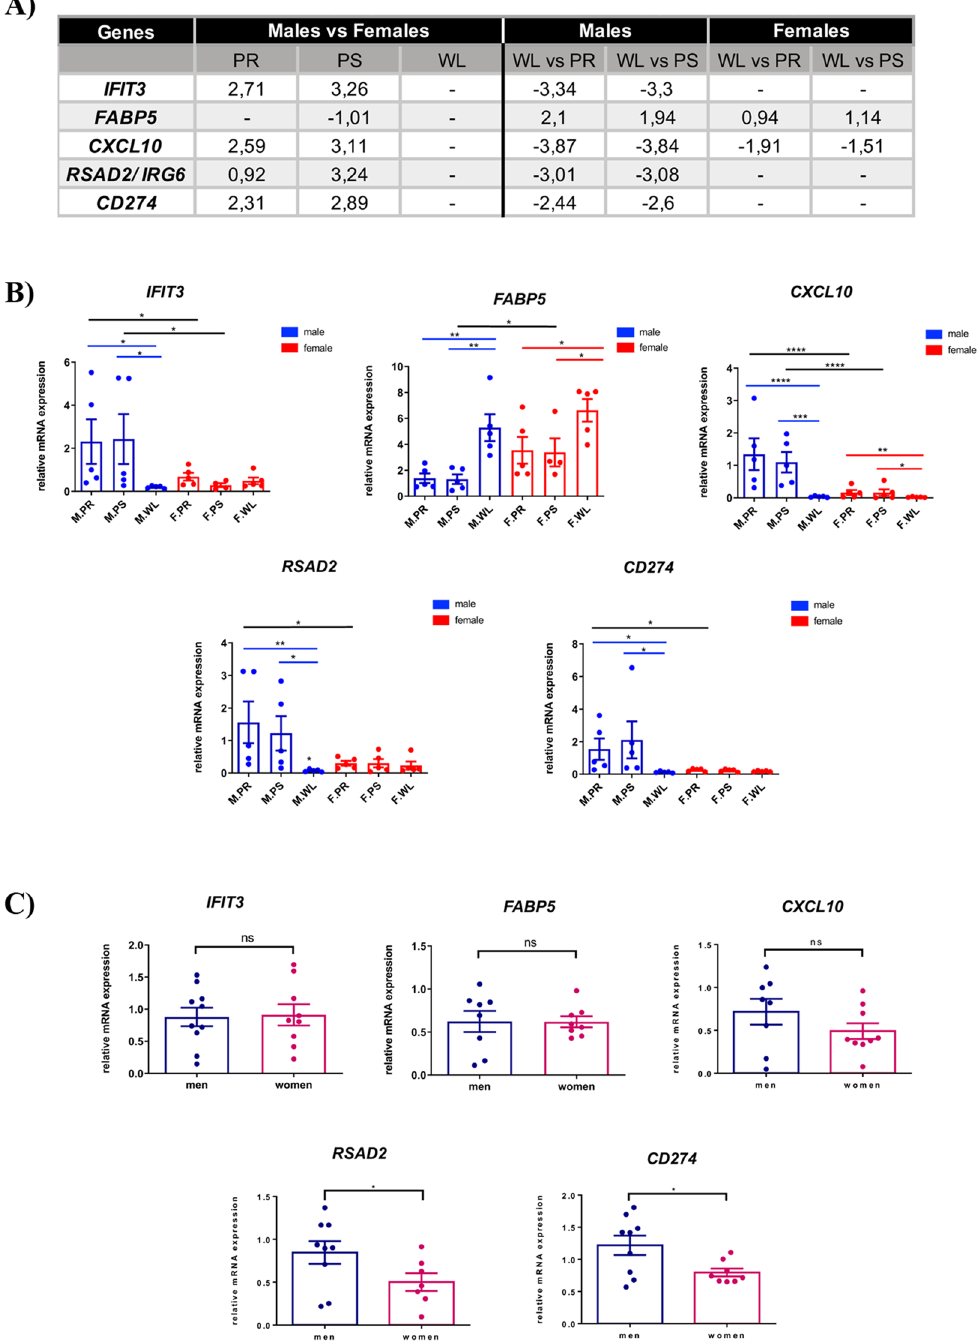
Figure 3. Validation of porcine renal IRI microarray assays by qRT-PCR experiments followed by evaluation of mRNA levels of selected targets in human ischemic kidney biopsies. ( A ) Expression values of five selected targets from microarray assays displaying time and sex differences. ( B ) Relative mRNA levels of FABP5, IFIT3, RSAD2, CXCL10, CD274 were measured and compared by qRT-PCR. For the time comparison, the different time points (PR, PS, WL) were compared with each other for each sex (blue male, red female). For the sex comparison, a selected time point in male was compared to the equivalent time point in female. Blue and red lines represent a time comparison in male or female, respectively. Black lines represent sex comparison at equivalent time points. ( C ) RSAD2, CXCL10, CD274, FABP5 and IFIT3 expression levels were evaluated by qPCR in post-surgery (PS) conditions from samples of 36–80 and 53–83 years old men and women, respectively (N > 7). * p value ≤ 0.05; ** p value ≤ 0.01; *** p value ≤ 0.001; **** p value ≤ 0.0001, ns: not significant. F female, M male, PR pre-ischemia, PS post-ischemia, WL one week